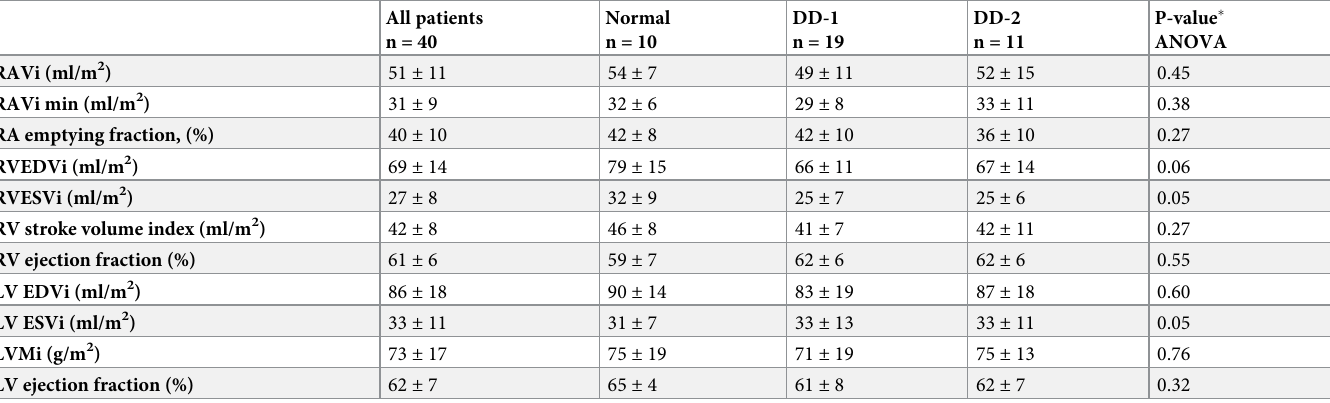
Data are shown as mean ± SD.